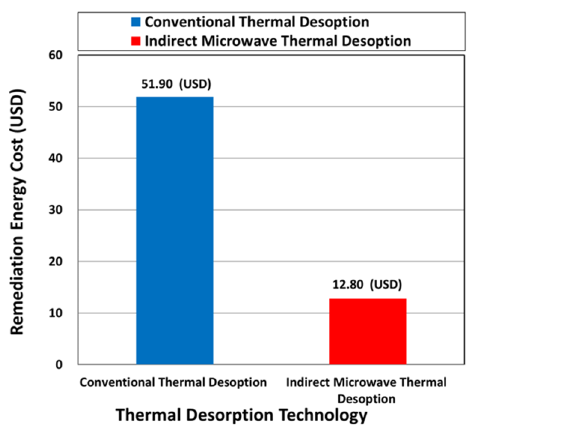
Figure 8. Comparison analysis of ( a ) Remediation energy cost (USD) and ( b ) Carbon dioxide emis- sions (ton-CO 2 ).